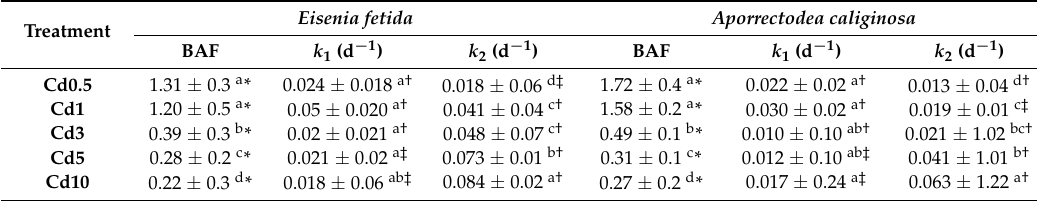
Table 3. Cd Bioaccumulation factor (BAF), uptake rate ( k 1 ) and elimination rate ( k 2 ) constants in the both earthworms exposed to different Cadmium concentrations. Eisenia fetida